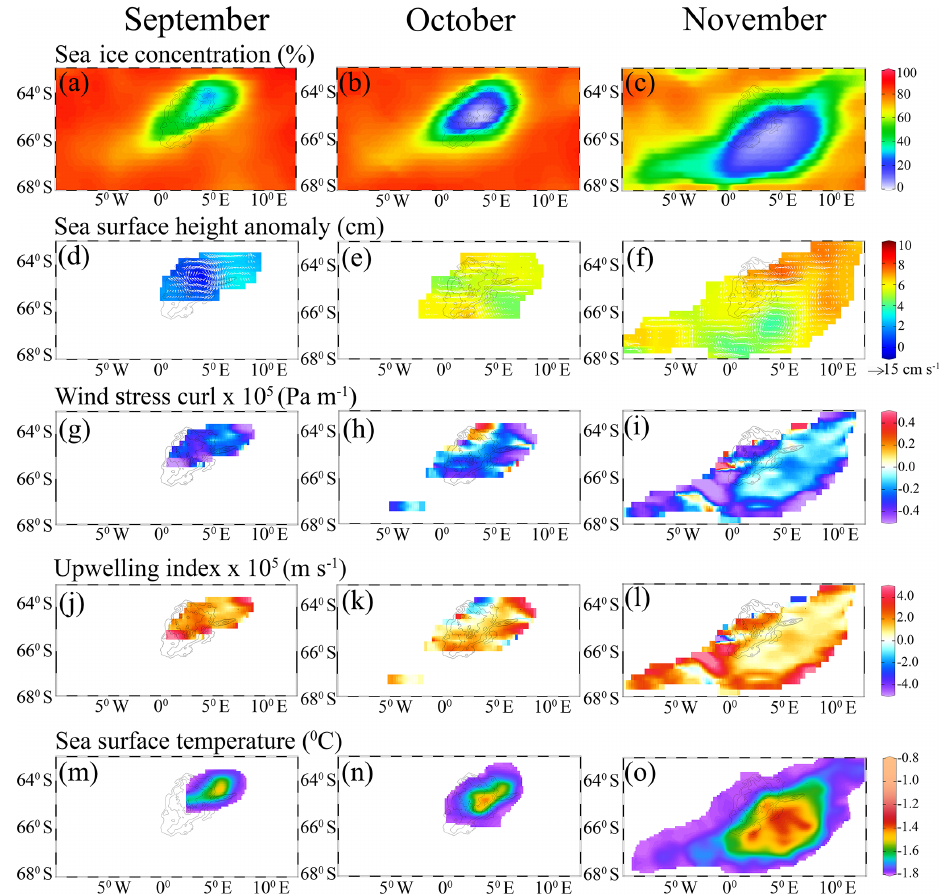
Figure 4. Monthly maps show (a–c) sea ice concentration, (d–f) sea surface height anomaly and geostrophic current velocity (white arrows), (g–i) wind stress curl, (j–l) upwelling index, and (m–o) sea surface temperature variability during the appearance of polynya from September to November